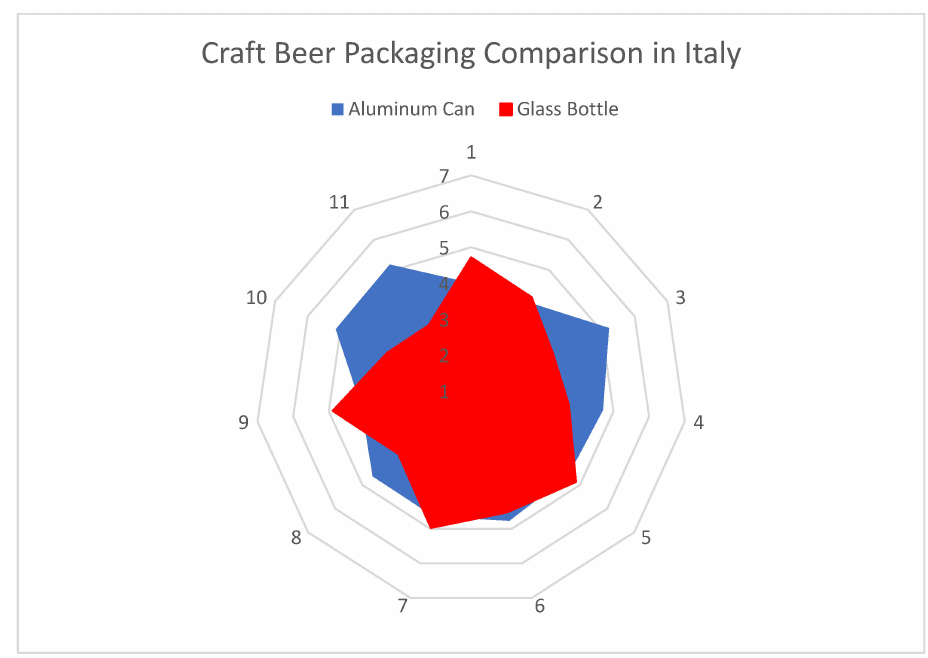
Table 7. Sample of Italian craft Figure 3. Comparison between Italian consumer perceptions of glass and can packaging for craft Table 7. Sample of Italian craft breweries. beer in (level of preference from 1 to 7). Table 7. Sample of Italian craft breweries. Table 7. Sample of Italian craft breweries. Table 7. Sample of Italian craft breweries.